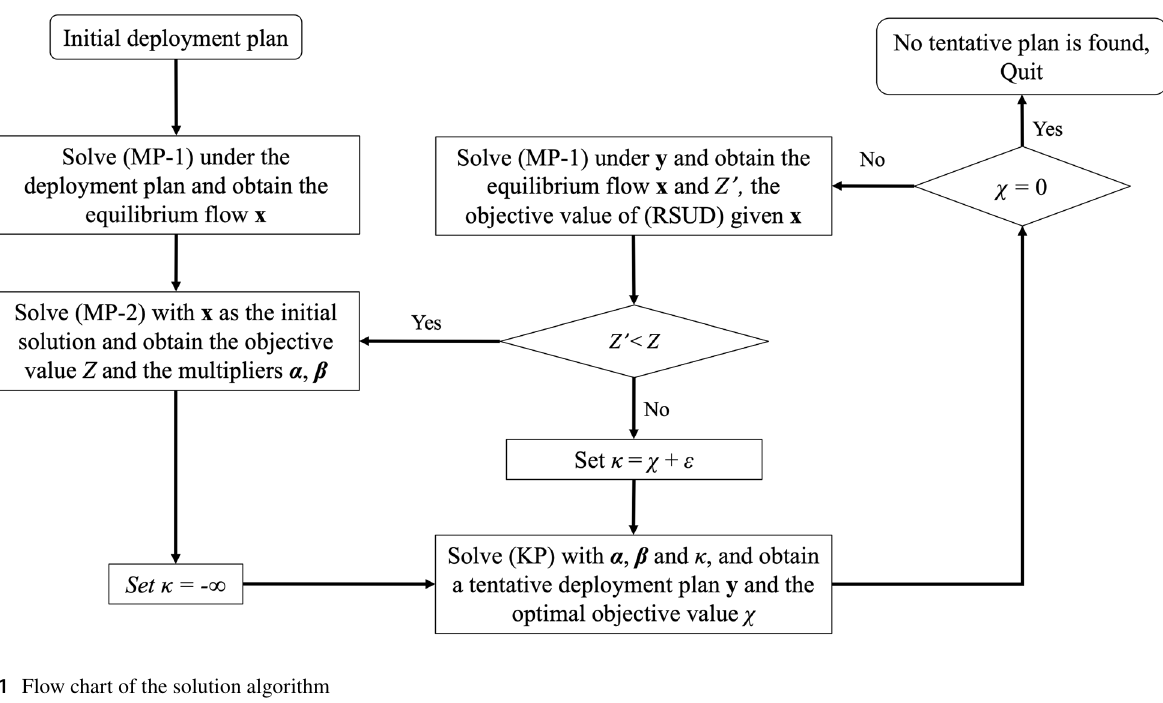
Fig. 1 Flow chart of the solution algorithm